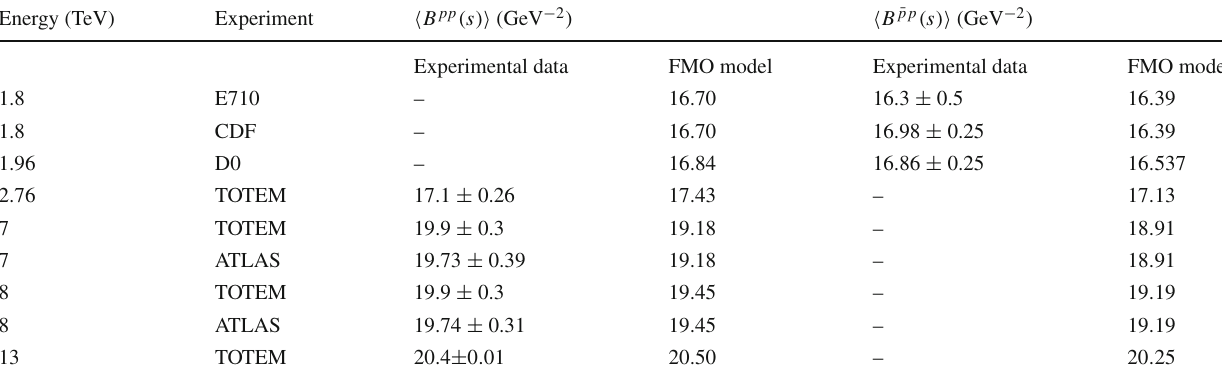
Table 4 Experimetal values of slopes of pp and ¯ pp differential cross sections at TeV energies and the averaged slopes calculated in FMO model Energy